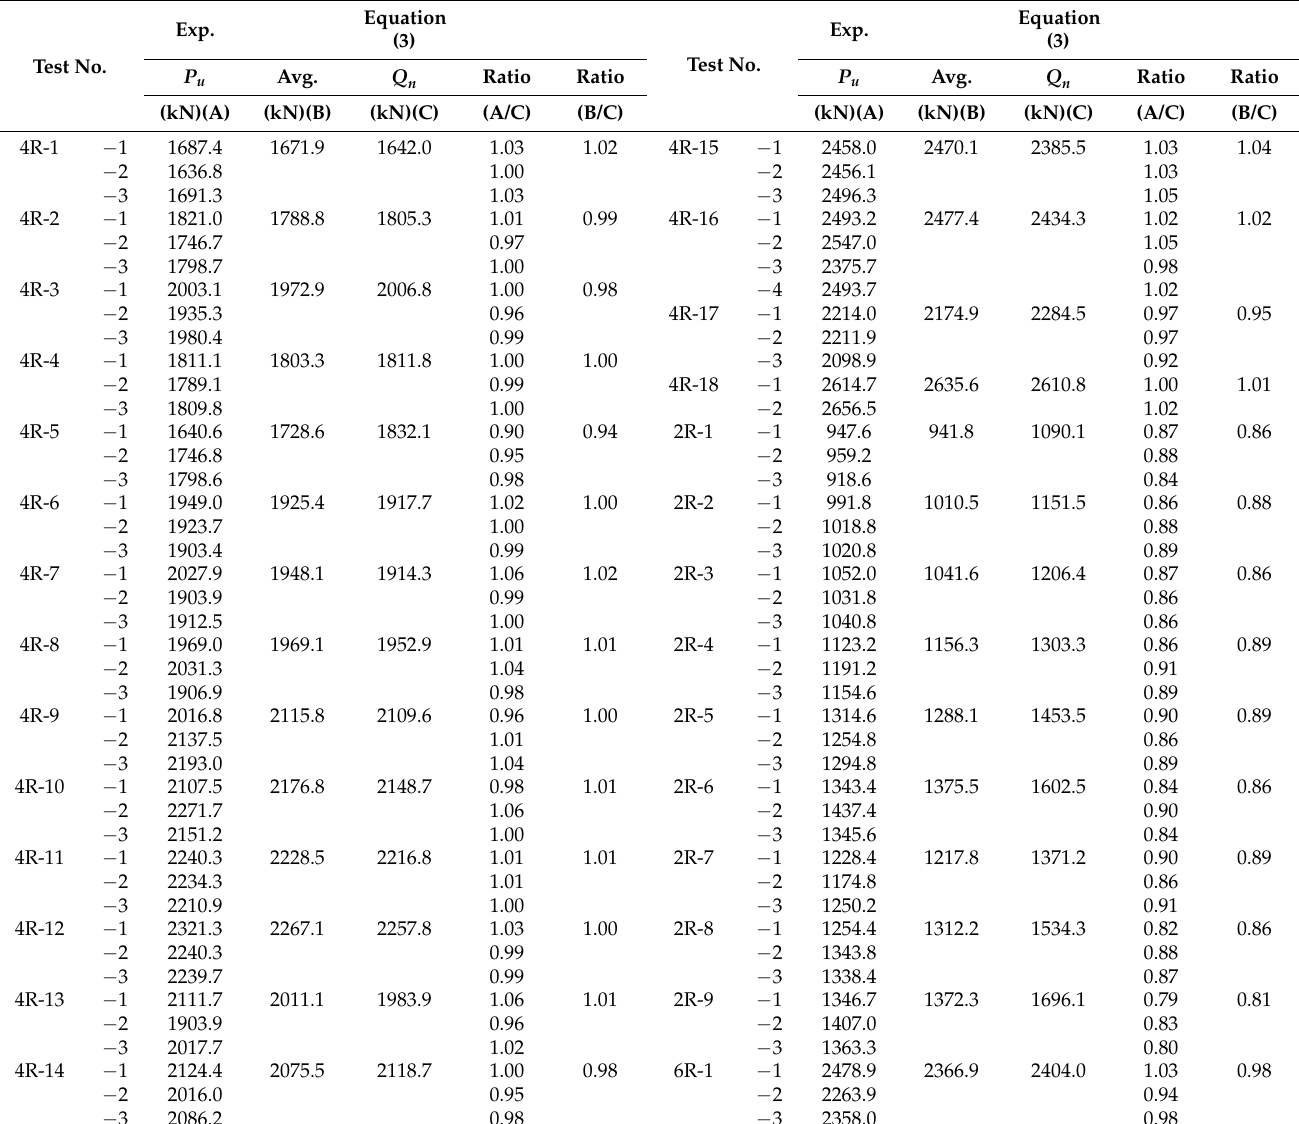
Table 17. Comparison of experimental resistance and estimated results (Equation